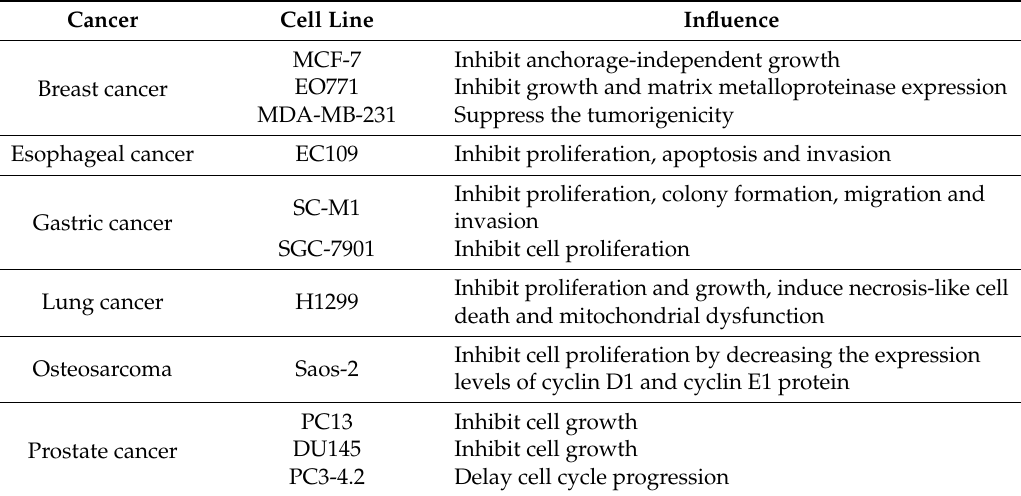
Table 1. The effect of MBP-1 on cancer cell